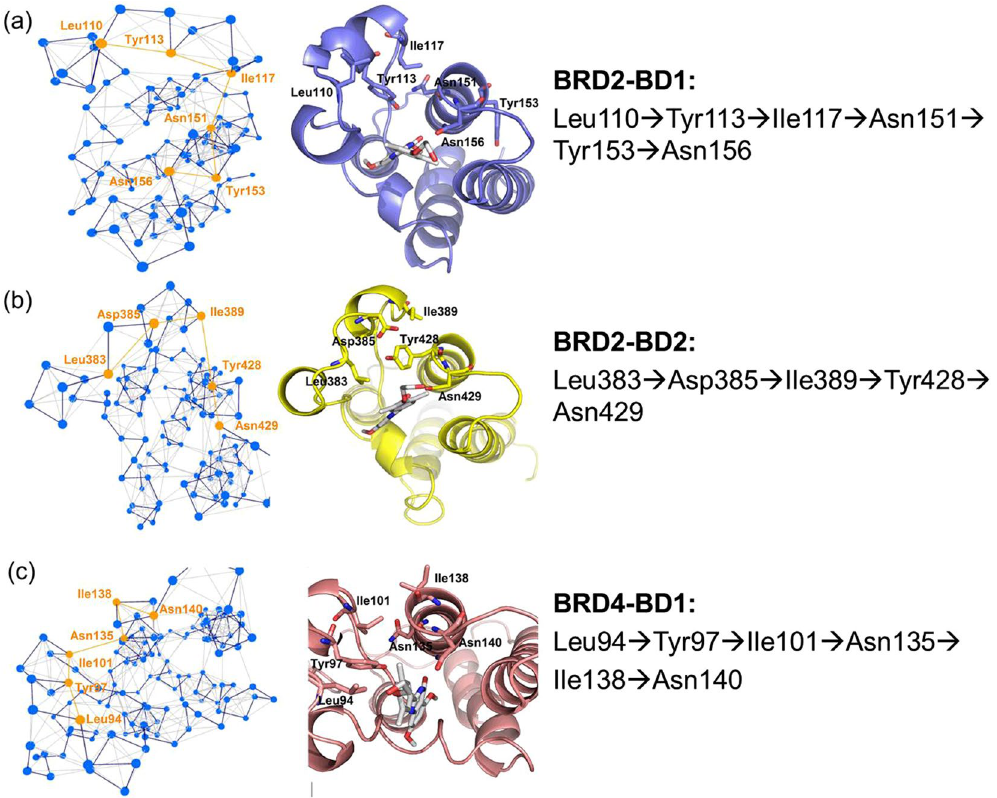
Figure 4. Shortest communication path between ZA and BC loops and the corresponding structure in ( a ) BRD2-BD1, ( b ) BRD2-BD2 and ( c ) BRD4-BD1 systems.